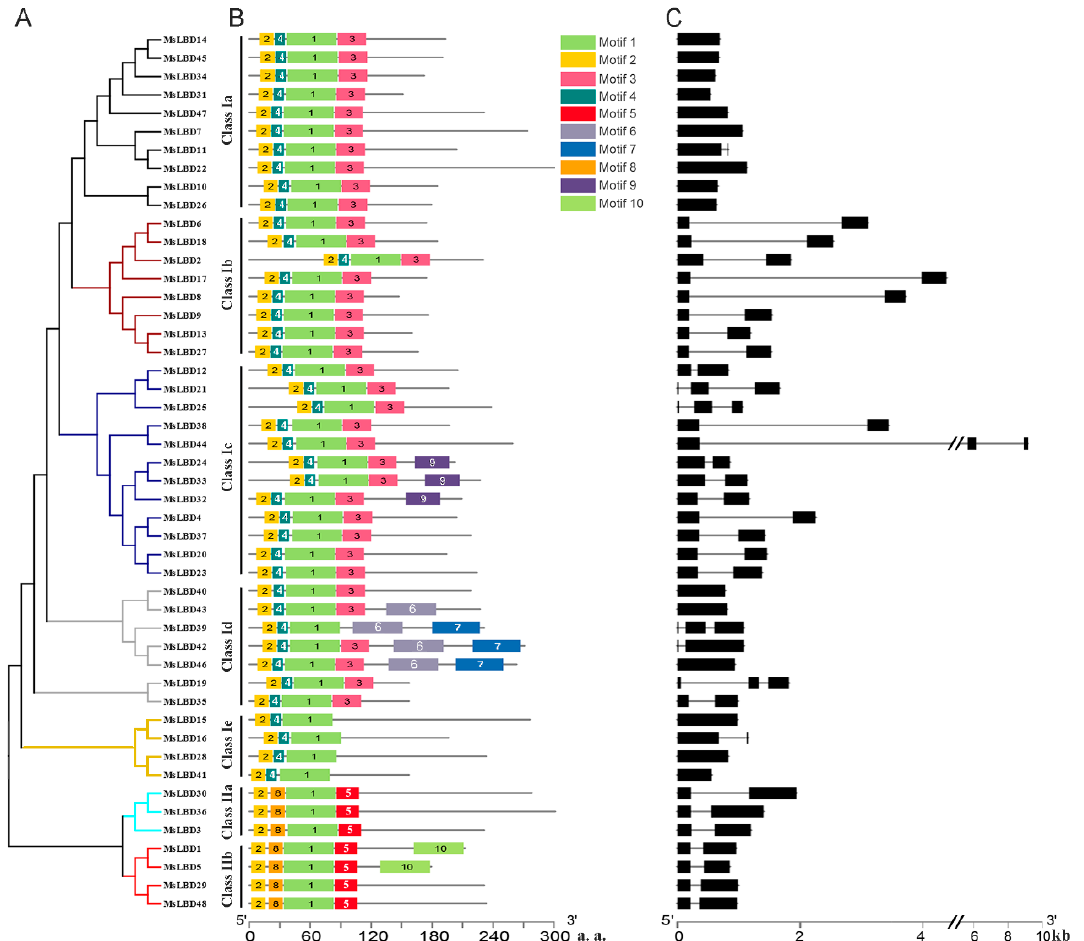
Figure 6. Features of 48 MsLBDs and their gene structure. ( A ) Homology analysis of MsLBDs from alfalfa. The neighbor-joining (NJ) tree was constructed with full-length sequence using MEGA 7.0 with bootstrap value of 1000. Subgroup is indicated in different colors. ( B ) Distribution of the conserved motifs of MsLBDs. ( C ) Gene structure of MsLBDs . Exon and intron are represented by solid line and box, respectively.